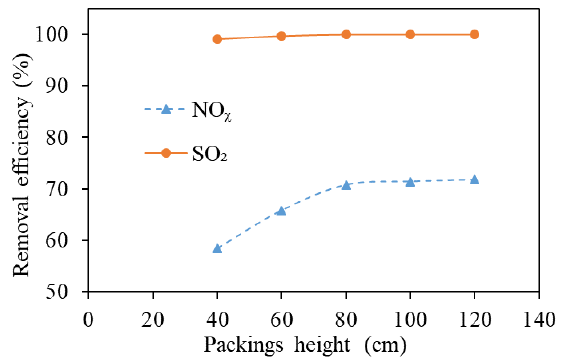
Figure 6. Effect of packing height on desulfurization and denitration efficiency of scrubber (operating conditions: discharge power = 19.5 W; gas flow rate = 5 L/min, scrubbing solution = 1% NaOH solution, spray density = 7.6 m (cid:2871) /(m (cid:2870) ∙ h) , packing type = D g 6 mm Dixon ring).